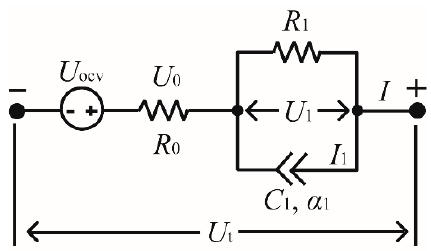
Figure 2. Fractional equivalent circuit model with a constant phase element (CPE).